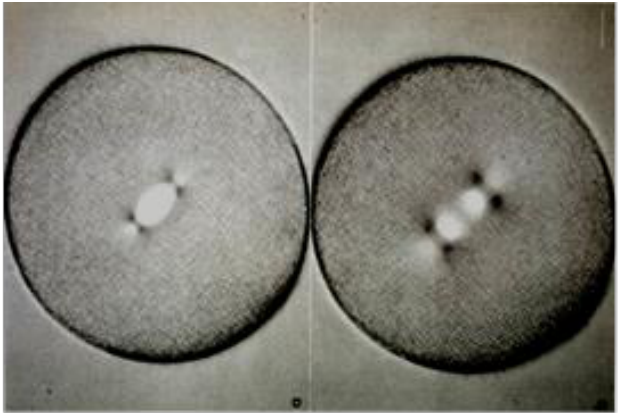
Figure 6. Mitotic spindles in living sea urchin eggs: metaphase ( left ) and mid-anaphase ( right ) viewed with polarization microscopy, similar to Inoue and Dan, 1951 [26]. Image from Salmon, E.D., 1982, Meth. Cell Biol. 25: 69–105. With permission from the author and the Copyright Clearance Center.